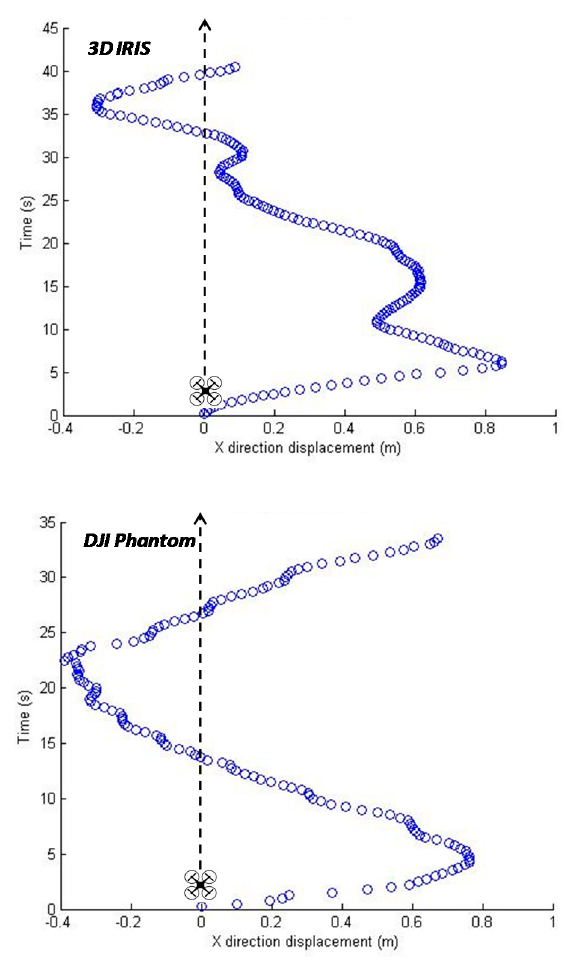
Figure 12. Estimated path of the sUAVs for the rectilinear motion test using image processing.